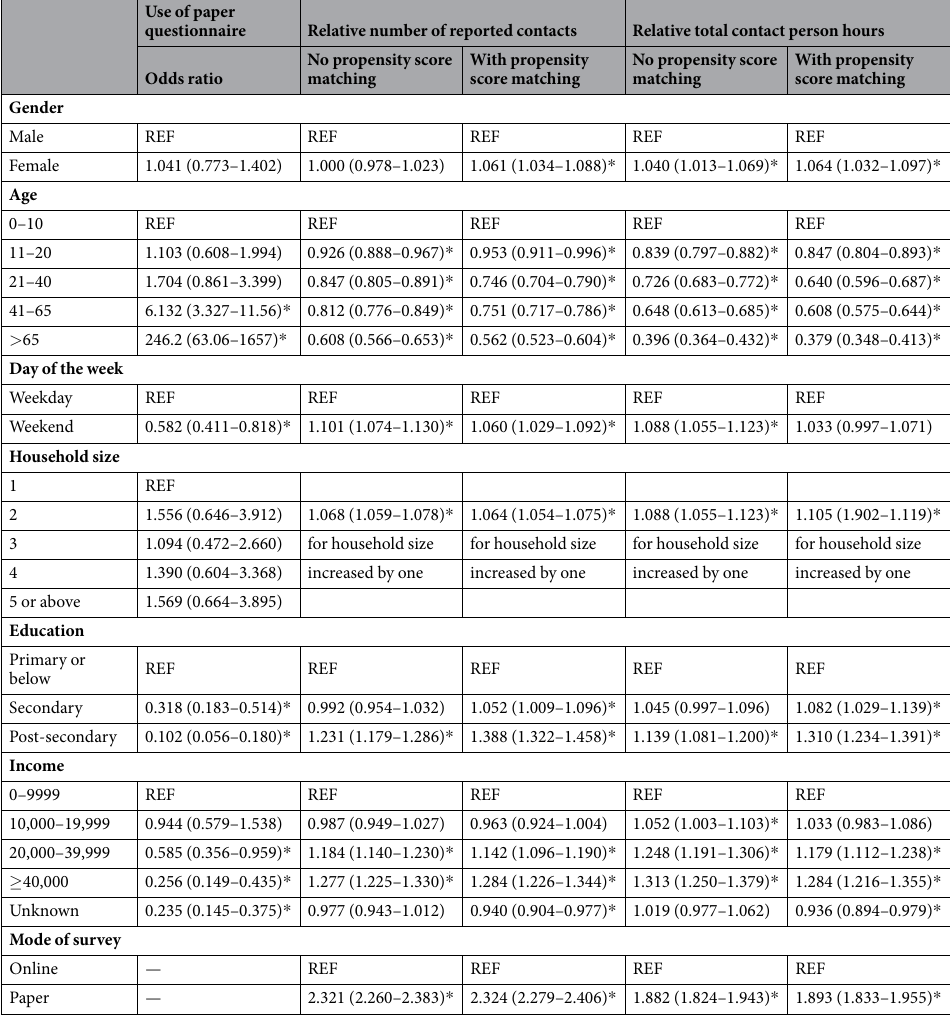
Table 2. The relative number of reported contacts and relative total contact person hours per participant per day by different characteristics of the survey